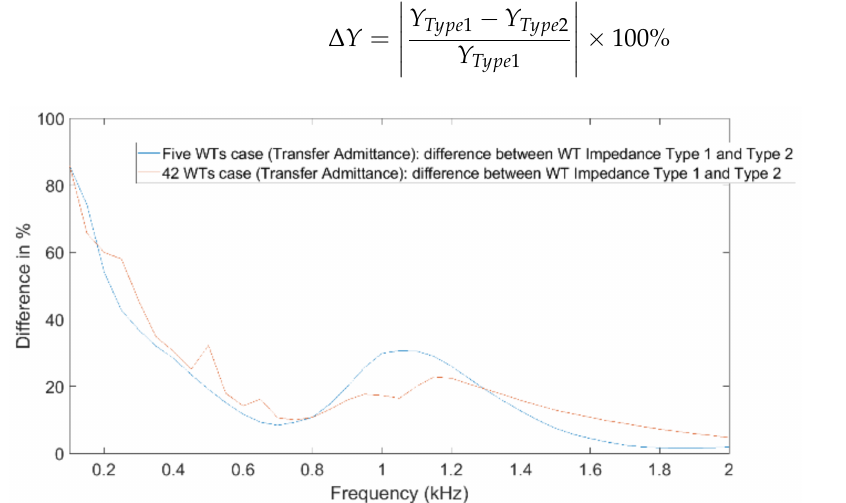
Figure 17. Difference (%) due to WT impedance: transfer admittance (A/V) from all turbines to one turbine (T1) in 5- and 42-turbine cases.